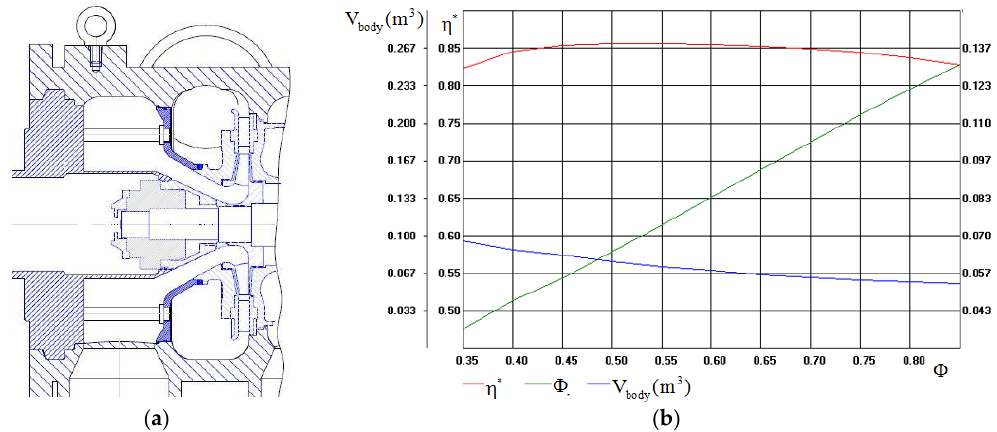
Figure 11. ( a ) Compressor for a turbo-expander unit and ( b ) comparison of compressor variants with different loading factors.